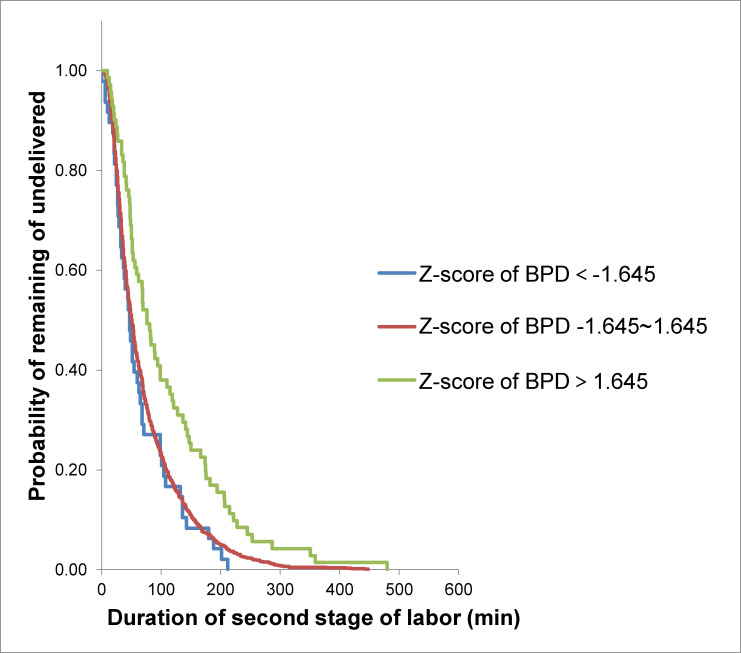
Kaplan-Meier analysis of the duration of second stage of labor according to Z-score of BPD in nulliparous women.